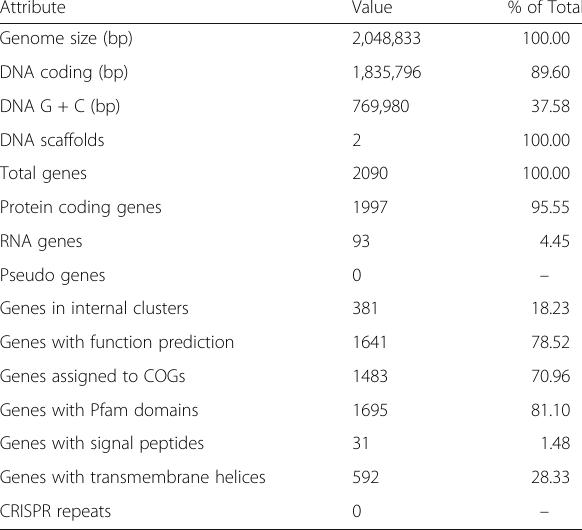
Table 4 Genome statistics